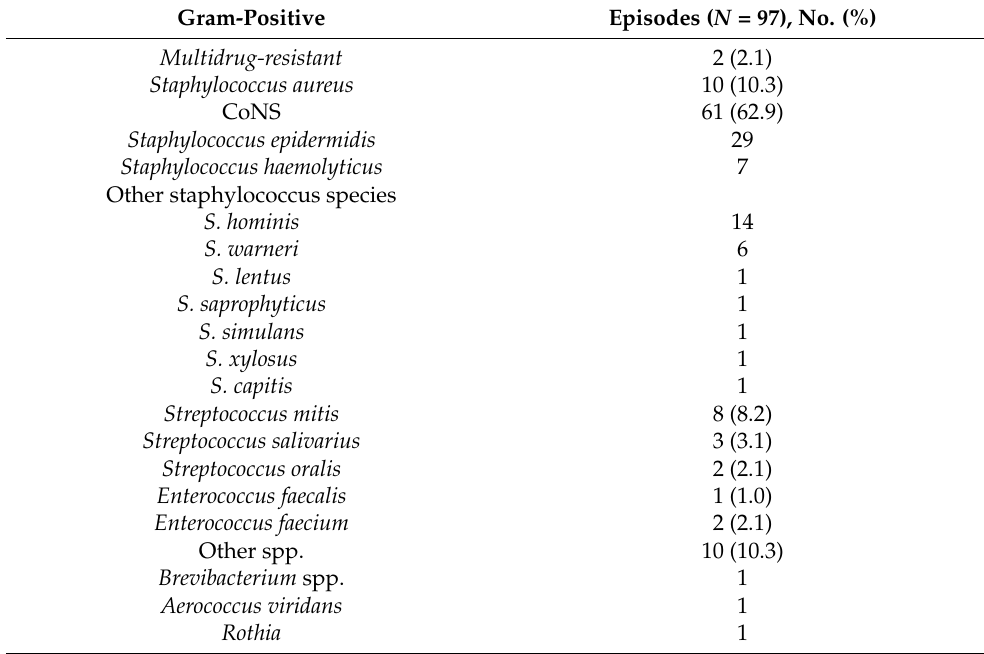
Table 2. The most frequent causative agents of